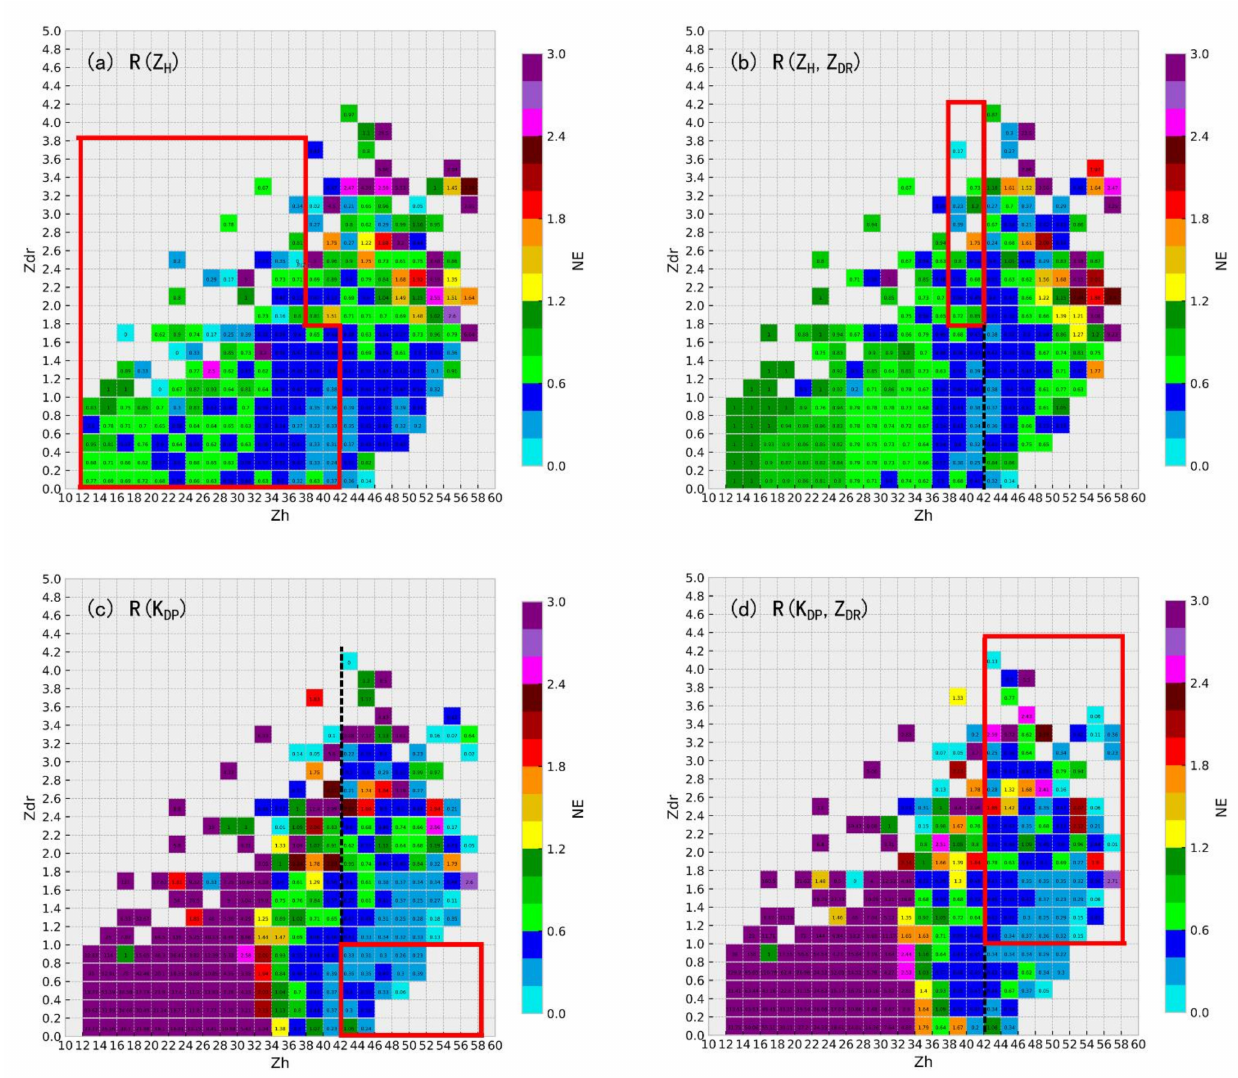
Figure 3. The hourly QPE normalized error of ( a ) R(Z H ), ( b ) R(Z H , Z DR ), ( c ) R(K DP ), and ( d ) R(K DP , Z DR ) for all eight monsoon rainfall events in Z H -Z DR space. Red frames represent the optimal thresholds ranges of four rainfall estimators to calculate composite QPE algorithm